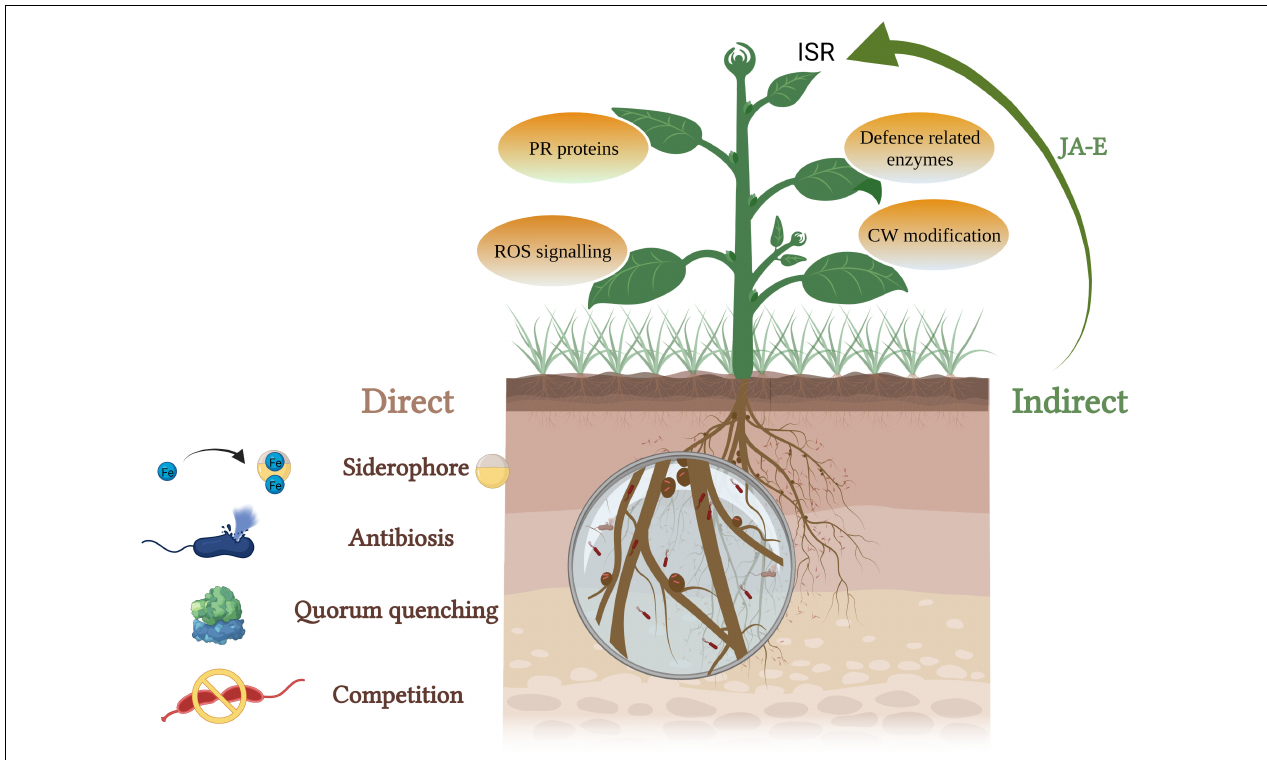
FIGURE 3 | PGPEB-mediated direct and indirect biocontrol of phytopathogens (JA, jasmonic acid; E, ethylene; ISR, induced systemic resistance; PR, pathogenesis related; ROS, reactive oxygen species; CW, cell